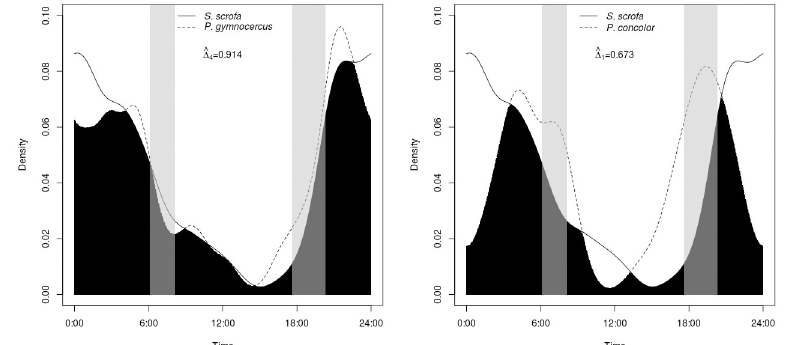
Fig 3. Activity patterns. Pairwise comparison of daily activity patterns of wild boar Sus scrofa , with a) Pampas fox Lycalopex gymnocercus , and b) the puma Puma concolor in central Argentina. Black area denotes overlap of activity. Grey columns represents sunrise and sunset.